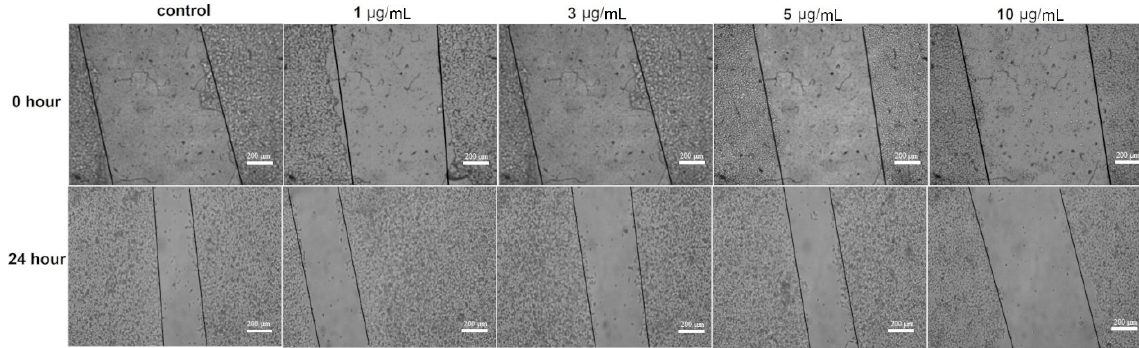
Figure 8. Effect of different AgNPs concentrations on the wound contraction in the fibroblast cell line.